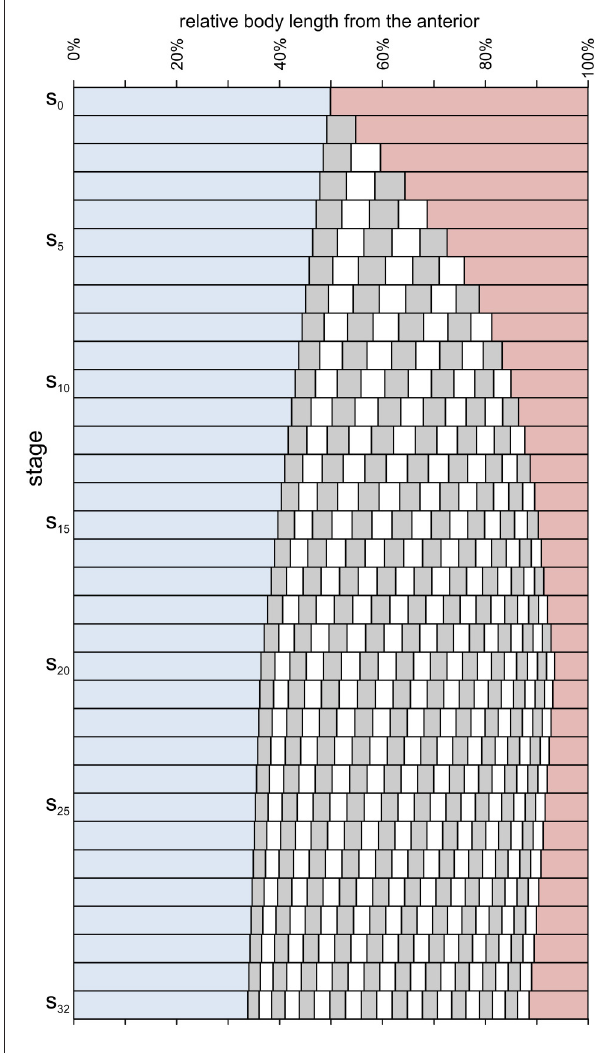
FIGURE 6 | Relative axial length of different body parts during meraspid (stages s 0 –s 19 ) and holaspid (stages s 20 –s 32 ) ontogeny of A. koninckii morphotype t 20 . Cephalic paraxial length, blue; thoracic segment lengths, alternating gray and white; pygidial length, red. (i) a